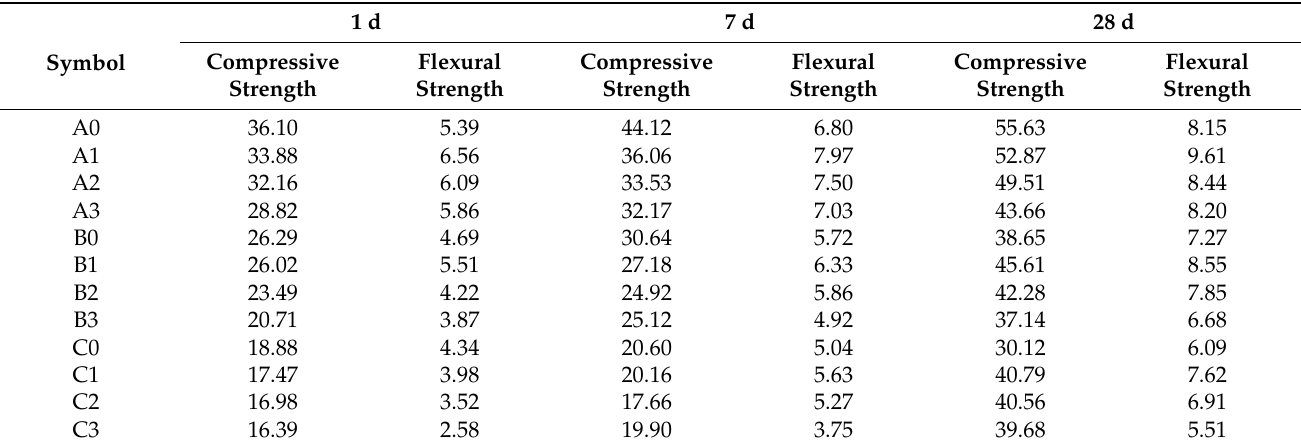
Table 3. Compressive and flexural strengths of mortar test blocks at 1 d, 7 d, and 28 d. (Unit: